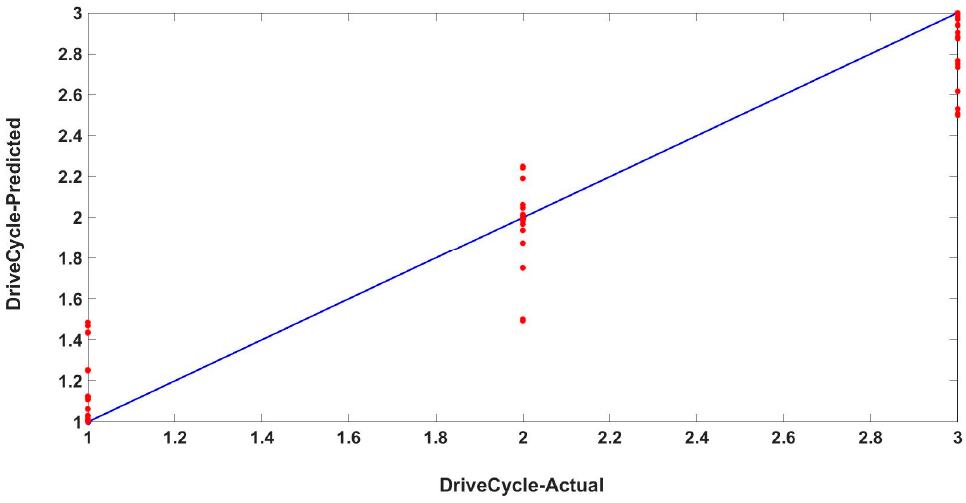
Figure 9. Predicted and actual drive cycle match for a real-world test data.